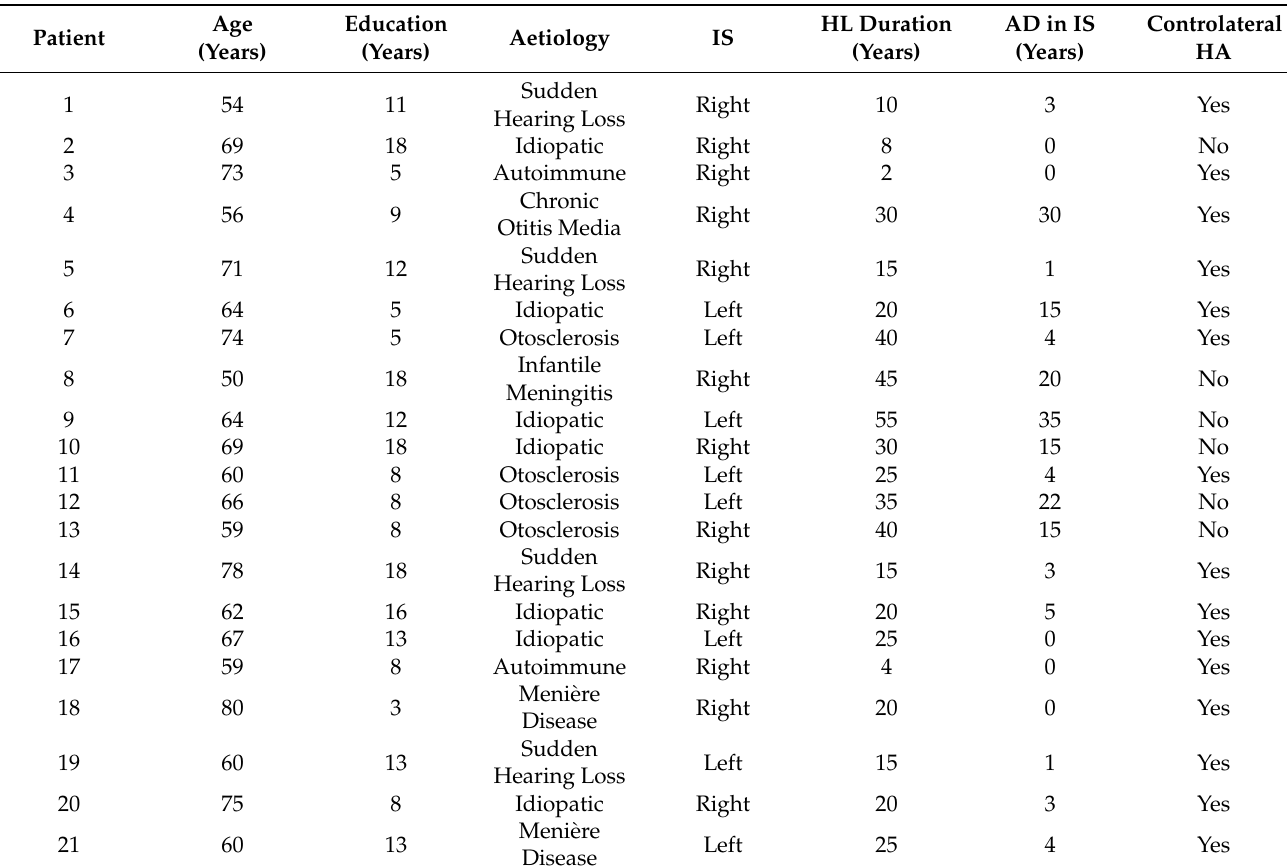
Table 1. Clinical and demographic characteristics of